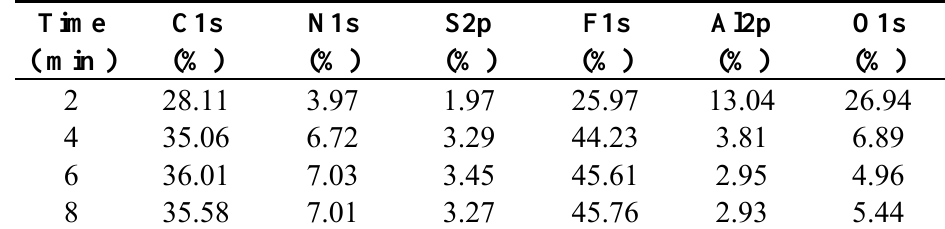
Table 1. Atomic concentrations of polymeric films formed by different electrochemical polymerization